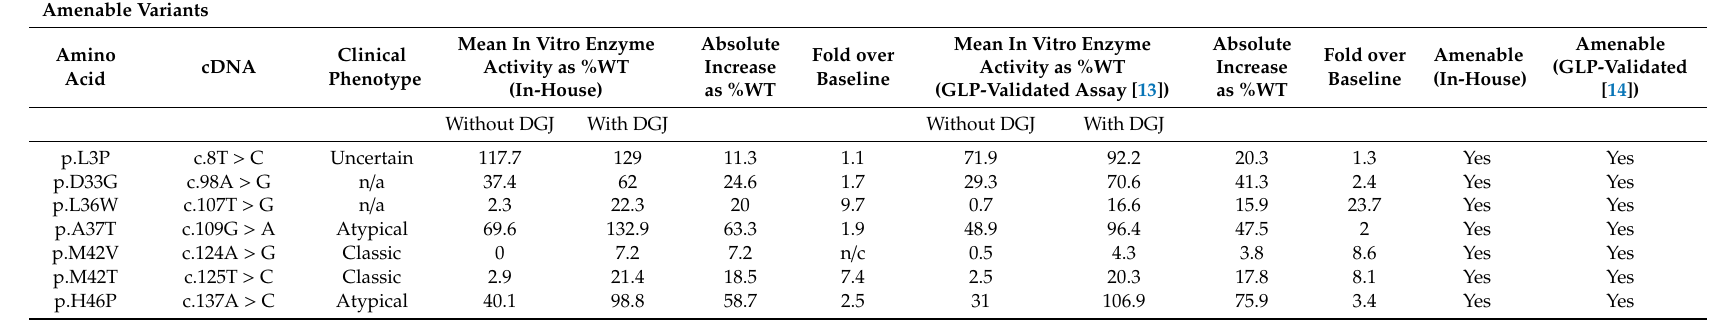
Table A2. GLA variant enzyme activity and amenability table. Upper: amenable variants; lower: non-amenable